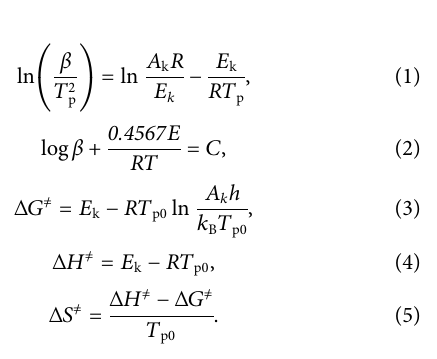
Hirshfeld surfaces viewed from the top (A) and bottom (B) . (C) Intermolecular interactions around compound 6 .